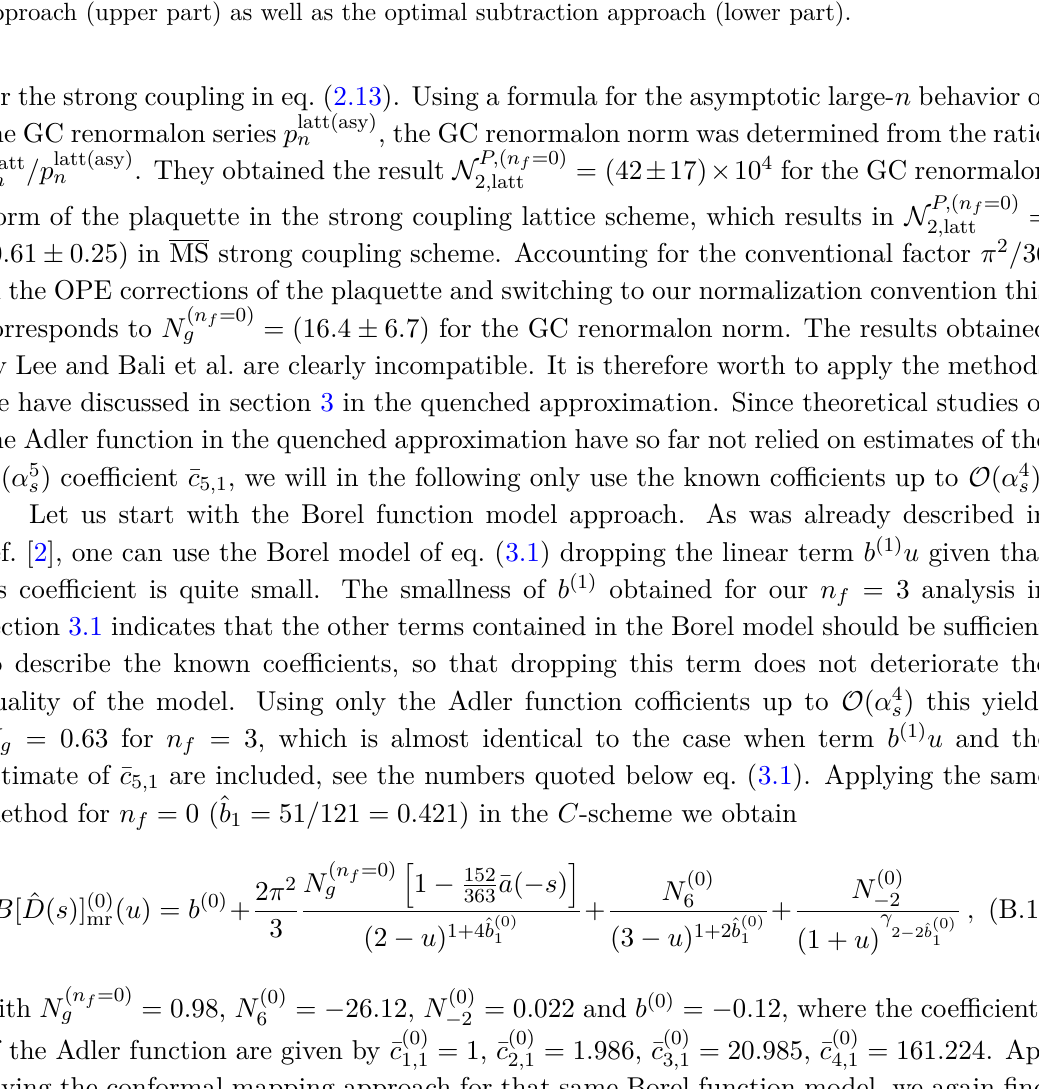
) using the conformal mapping s